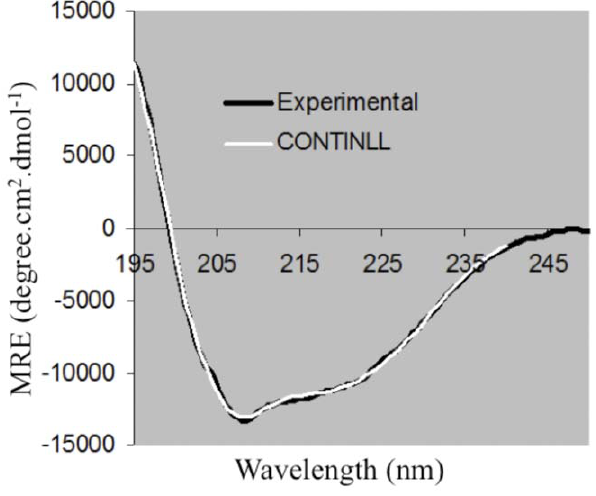
Figure 2. Far-UV CD spectrum of Zbed4 (black curve) and curve obtained using the CONTINLL program (white curve). The CONTINLL-calculated curve conforms well to the experimental spectra of Zbed4. SELCON and CDSSTR-calculated curves (not shown) were essentially identical to that of CONTINLL.